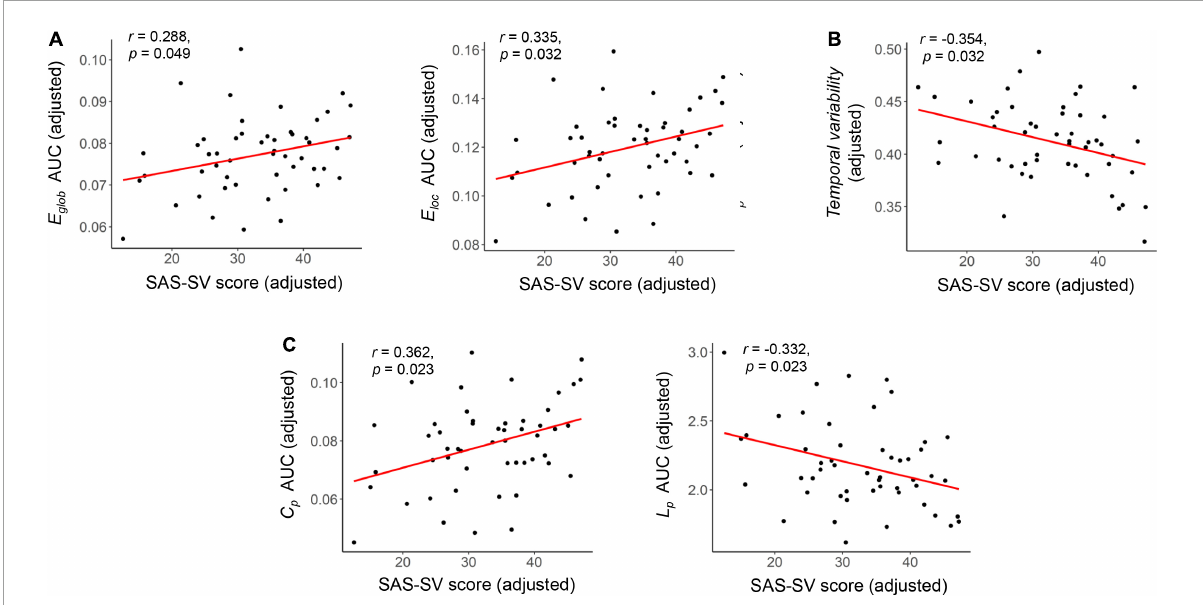
FIGURE3 Results of the partial correlations between the short version of the smartphone addiction scale (SAS-SC) score and each global brain network metric. (A) Results on the E glob and E loc of static brain networks. (B) Results on the temporal variability of dynamic brain networks. (C) Results on the C p and L p of static brain networks (as validation analyses). The partial Pearson correlation coefficients ( r ) and corrected p values are presented.